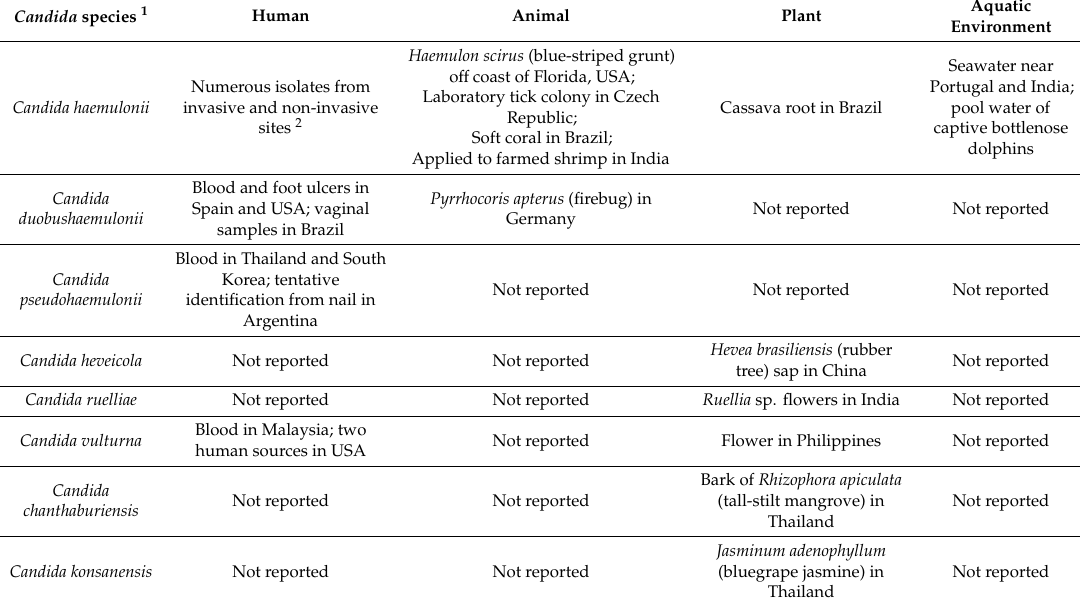
Table A1. Sites of isolation of Candida species closely related to Candida auris by ribosomal DNA sequencing analysis, grouped by host or environment